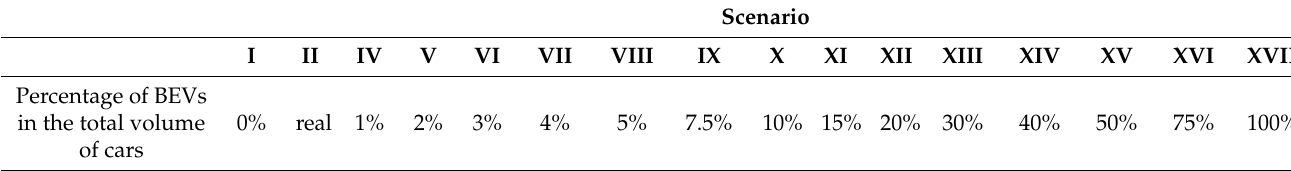
Table 5. Scenarios applied in